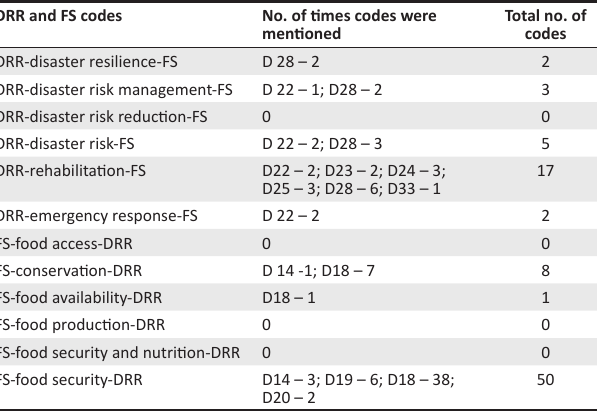
TABLE 5: Interlinkages between food security and disaster risk reduction policy and